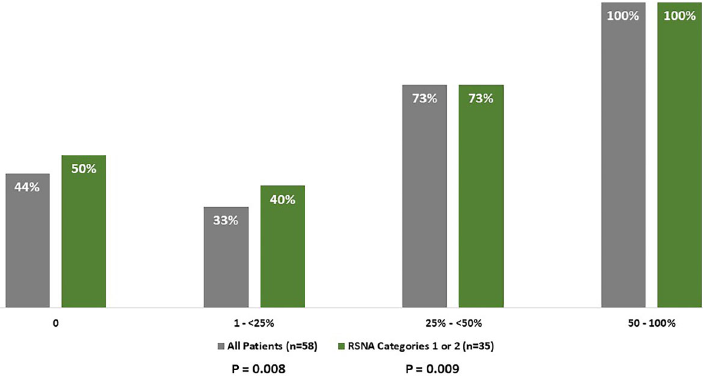
Figure 3. Death rate according to extent of in fl ammatory changes in all patients and in Radiological Society of North America (RSNA) categories 1 and 2 (Fisher ’ s exact